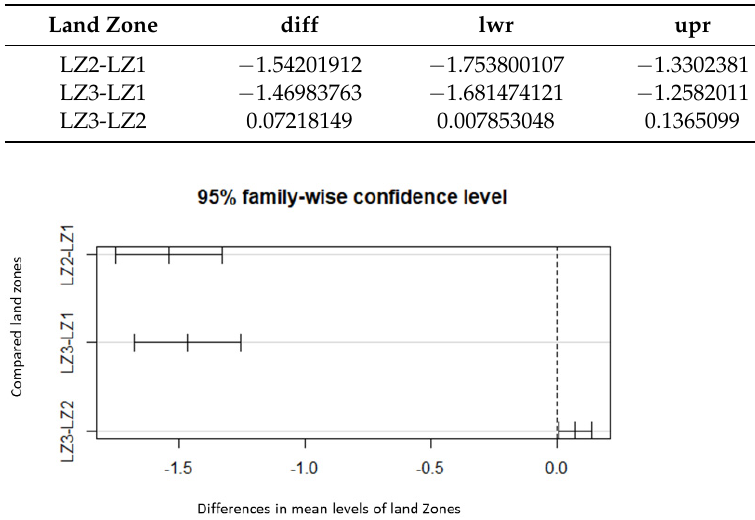
Table 2. Significance tests for land price per m 2 in USD for the designated land zones.